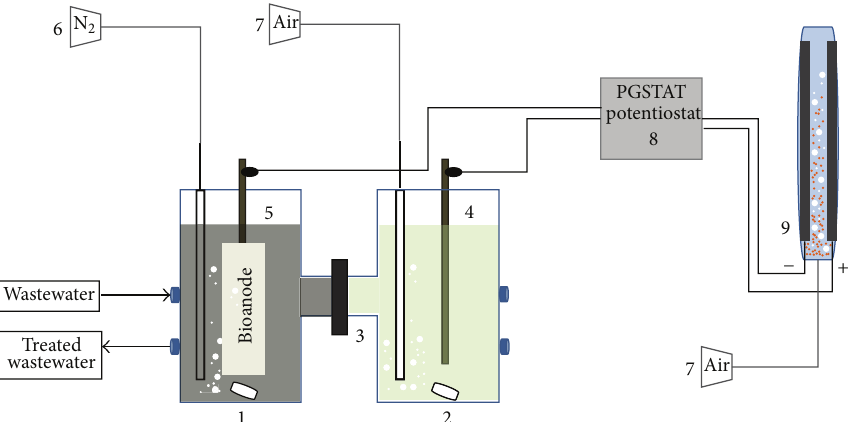
Figure 1: Experimental set-up; 1: anode chamber, 2: cathode chamber, 3: Sterion Cation Exchange Membrane, 4: cathode, 5: anode, 6: nitrogen supply, 7: air supply, 8: AutoLab PGSTAT 320 N potentiostat, and 9: electrochemical tubular glass reactor with graphite sheets and